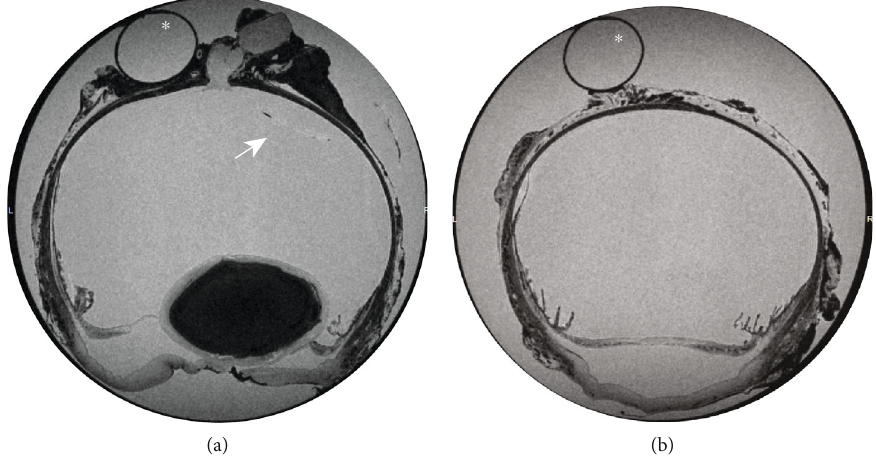
Figure 2: (a) Axial and (b) peripheral transverse sections of the enucleated canine globe (OS) imaged with high fi eld 9.4T MRI. Note the corneal stromal loss consistent with the patient ’ s bacterial keratitis, the shallow anterior chamber with notable loss of aqueous humor, and the multifocal undulation of the neurosensory retina (white arrow) consistent with multifocal retinal detachment which occurred artifactually, subsequent to globe fi xation and processing. The white asterisks denote the plastic drinking straw used for globe positioning during image